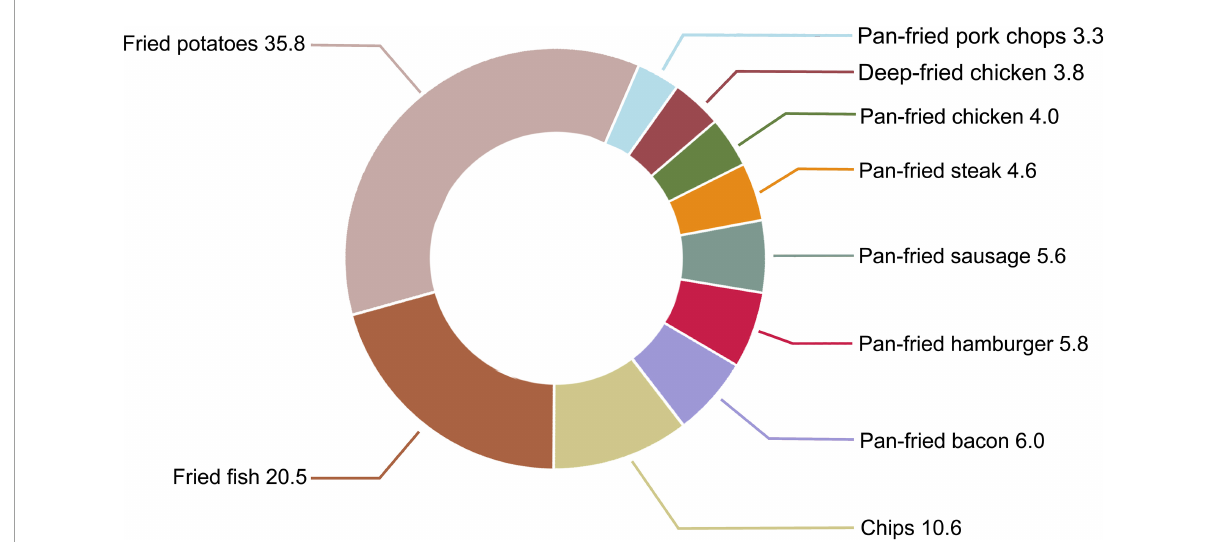
FIGURE4 Proportion (%) of each fried food in total fried food consumption in our study population.